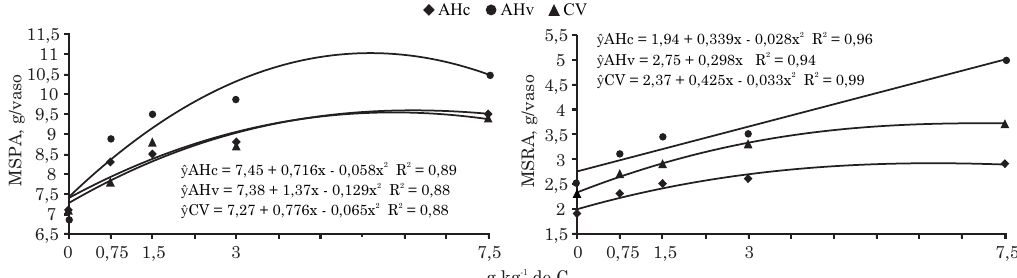
Figura 1. Produção de matéria seca da raiz (MSRA) e matéria seca da parte aérea (MSPA) de Zea mays em função de doses de carbono aplicadas ao solo via ácidos húmicos comerciais (AHc), ácidos húmicos extraídos de vermicomposto (AHv) e carvão vegetal ativado (CV).